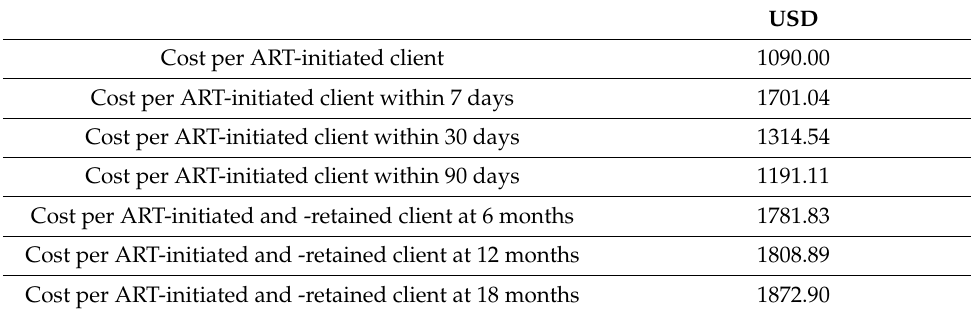
Table 3. Costs a per outcome for scenario analysis (in 2018